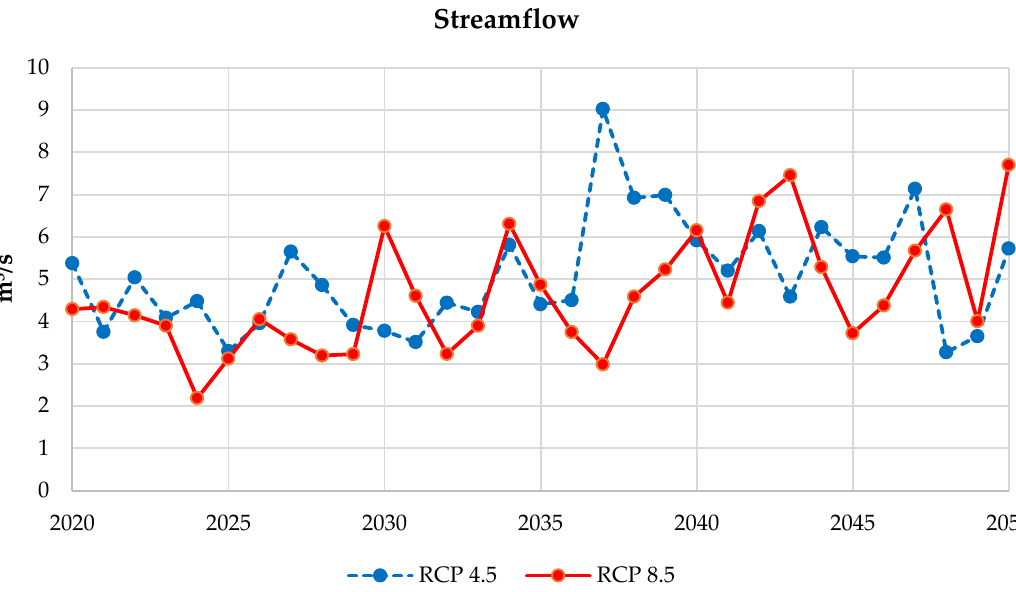
Figure 6. The projected streamflow for 2020–2050.